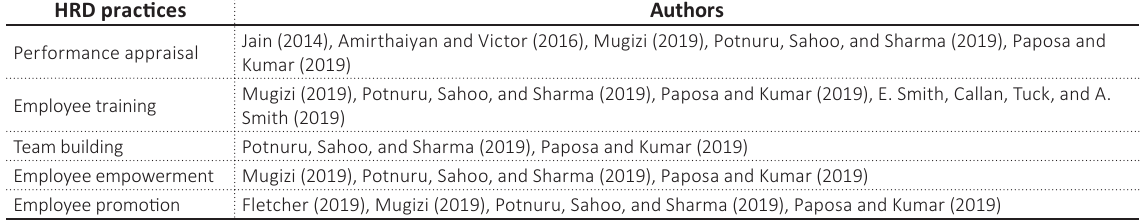
Table 1. Examples of HRD practices in the literature HRD